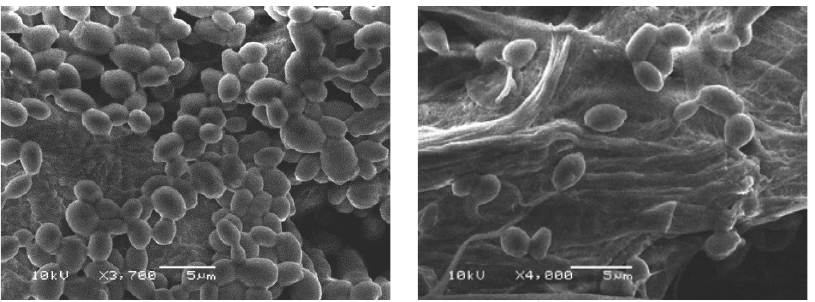
Figure 3. Candida albicans in ethanol as control ( left ); Candida albicans treated with synthesized compound 7 ( right ).